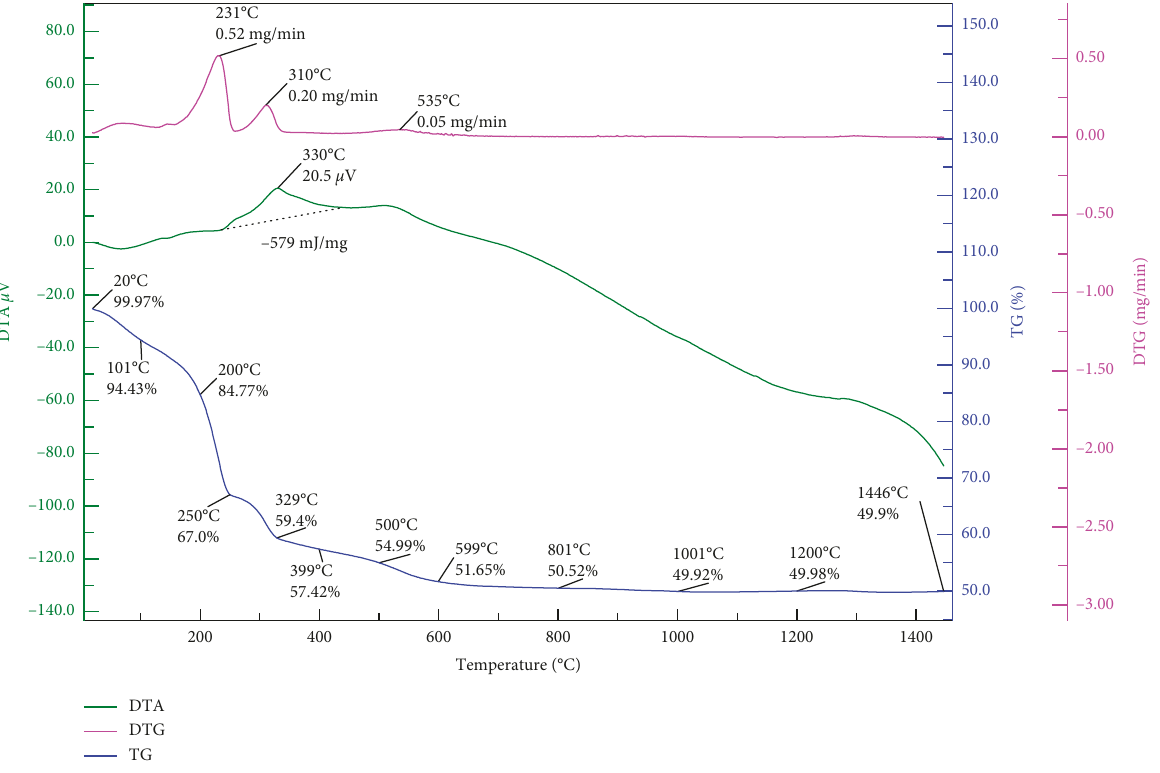
Figure 10: Simultaneous TGA/DTA/DTG curves of PANI/PVC-PEDOT: PSS-ZrP